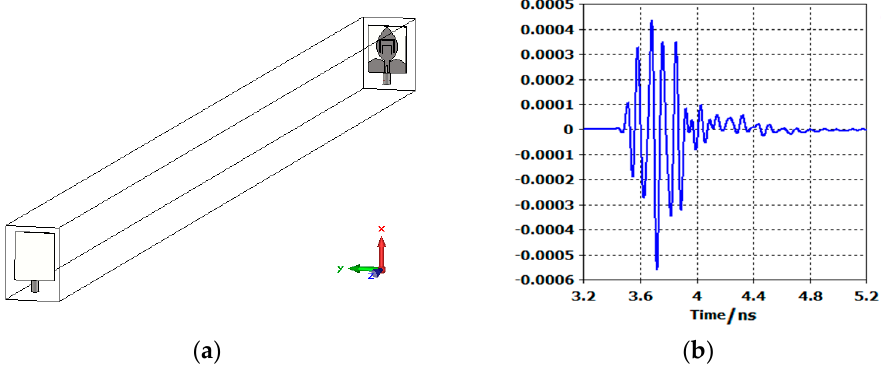
Figure 10. Conformal antenna and its performance in time domain: ( a ) conformal antenna; ( b ) re- ceived signal.